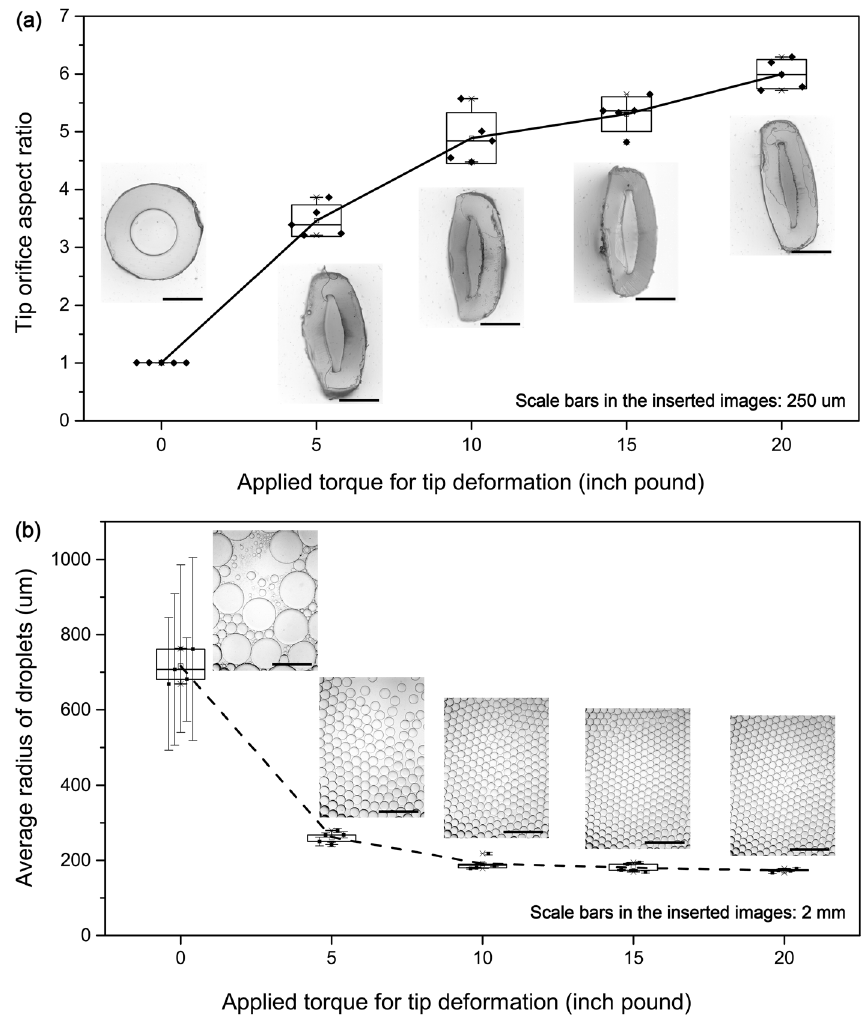
Figure 3. Controlled pipette tip modification by changing torque forces with constant deformed length (~ 3.5 mm) and corresponding pipette droplet generation: ( a ) cross-section aspect ratios of pipette tips versus applied torque for tip deformation, tip deformed lengths are ~ 3.5 mm, inserted images are typical deformed tip orifice cross-sections; ( b ) average radii of water droplets generated with torque deformed pipette tips, each point represents average radius and standard deviation (error bar) of droplets generated by the corresponding deformed tip and the inserted images are droplets generated by the tips with orifice cross-section images inserted in ( a ). Based on the curves, specific tips and droplets can be prepared by applying the corresponding torque